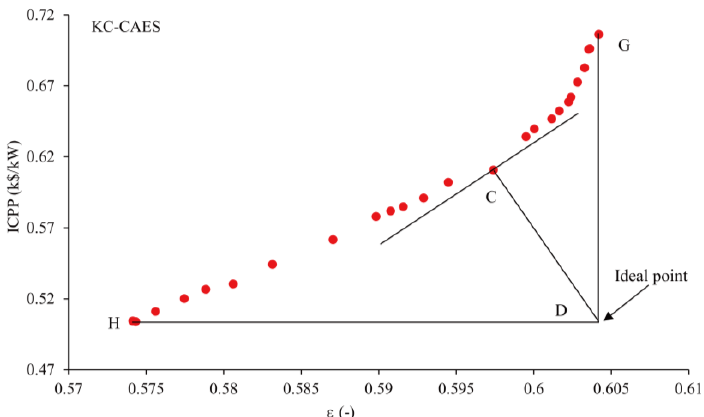
Figure 10. Pareto frontier of KC-CAES for ICPP versus ε using multi-objective GA. Table 2. Optimal parameters of the two systems.